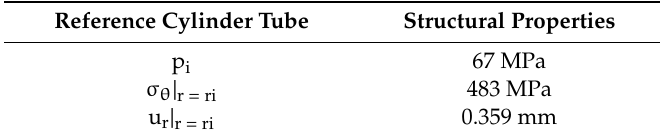
Table 3. Reference cylinder tube stress and radial deformation at the